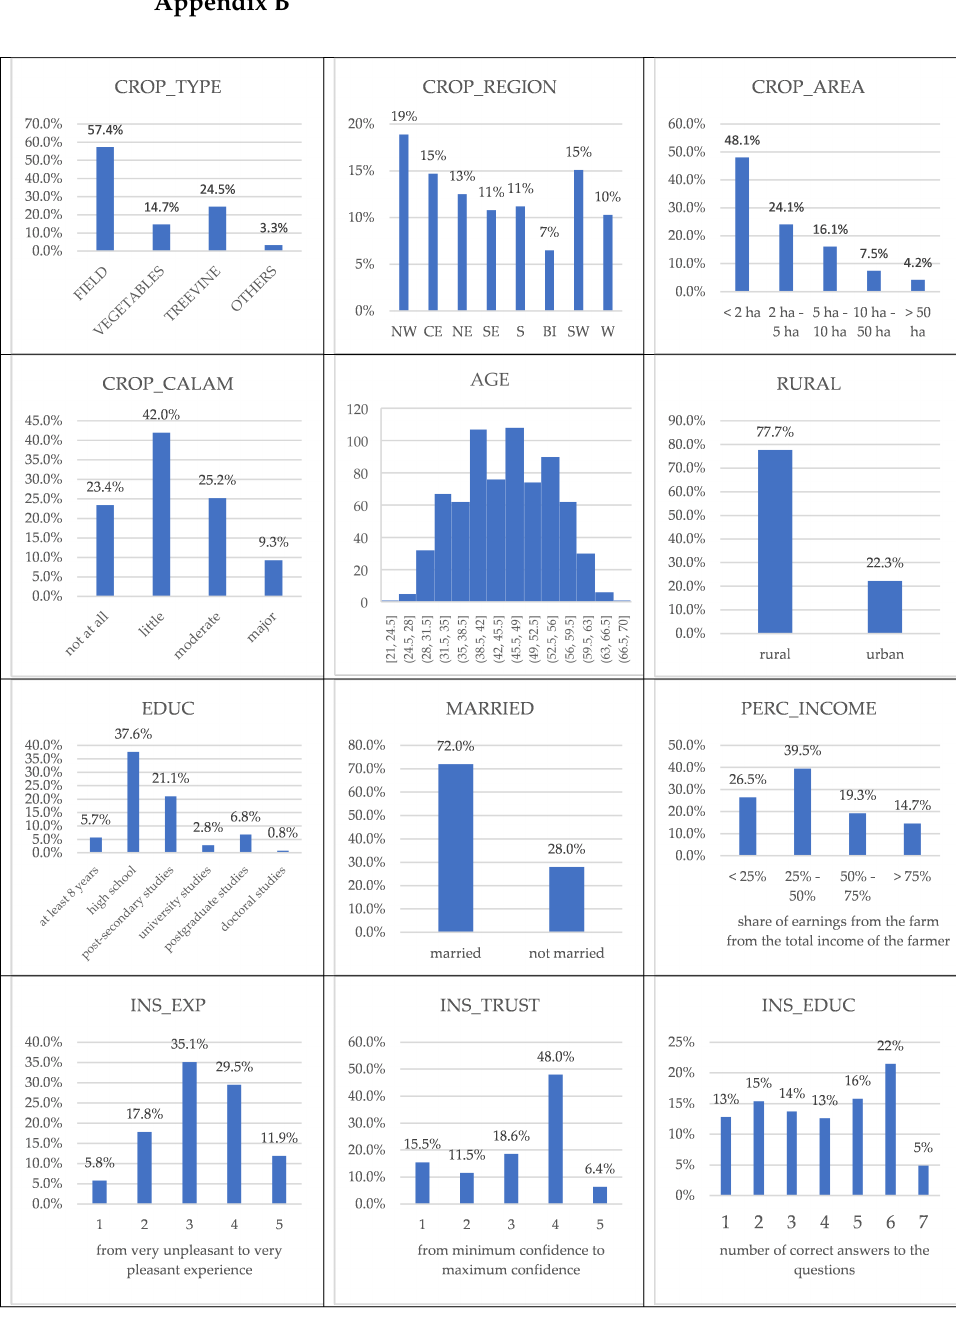
Figure A1. Descriptive